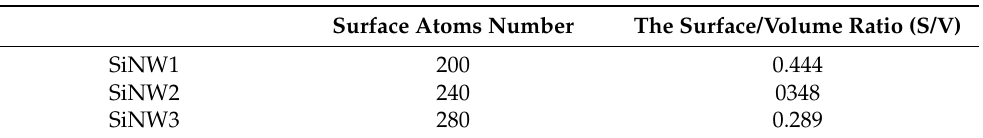
Figure 3. The variation of average potential energy of each atom for all the Si NWs with time. Table 2. The statistics of the surface atoms number; the surface/volume ratio of all the Si NWs before relaxation at room temperature.